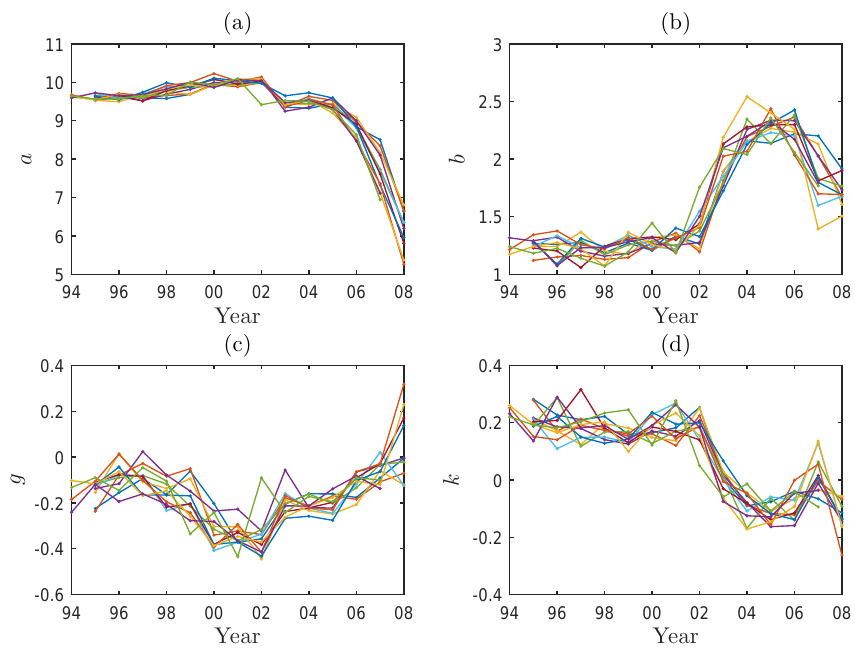
Figure 4. Time series plots of parameter estimates of the g-and-k model, where each panel corresponds to a parameter and each line within a panel corresponds to a month. The panels ( a ), ( b ), ( c ), and ( d ) correspond to the a , b , g , and h parameters, respectively.